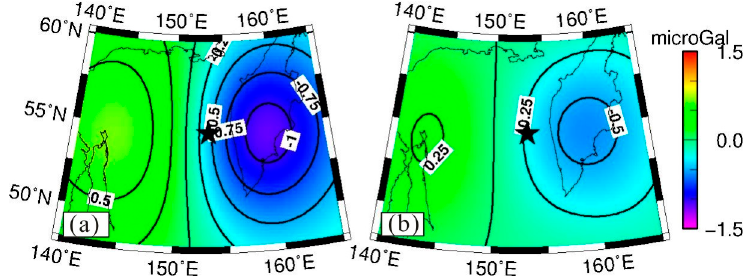
Figure 9. ( a ) Modeled gravity changes calculated by the dislocation theory in a spherical earth model [26]. ( b ) Modeled gravity changes calculated by the dislocation theory in a half-space earth model [24]. Seawater correction + P4M6 decorrelated filter + 350 km Gaussian smoothing has been applied to (a) and (b).